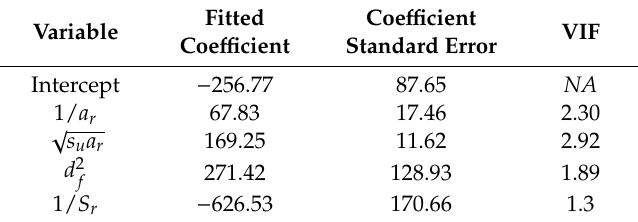
Table 4. Summary statistics for the proposed MLR model.